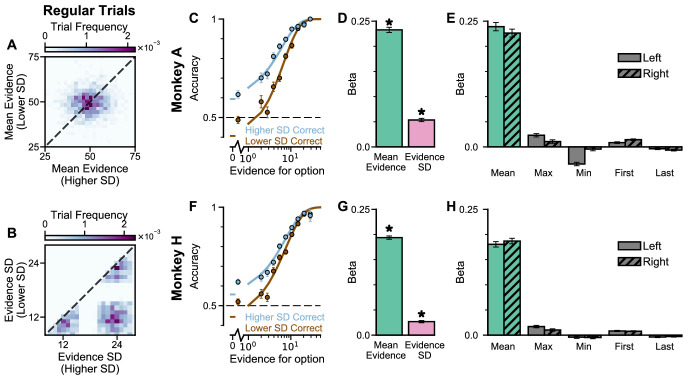
Extra information on Regular Trials, separated by subjects.In the regular-trials, each of the two streams is randomly chosen to be either narrow (μN∈[47,53], σN=12), or broad (μB∈[44,56], σB=24), then divided into ‘Lower SD’ or ‘Higher SD’ options post-hoc, depending on the sampled standard deviation of evidence relative to the other option. (A) The distribution of the mean evidence of ‘Lower SD’ and ‘Higher SD’ streams, across all regular trials for both monkeys. (B) The distribution of the evidence variability of ‘Lower SD’ and ‘Higher SD’ streams, across all regular trials for both monkeys. (C) The psychometric function of Monkey A when either the ‘Lower SD’ (brown) or ‘Higher SD’ (blue) stream is correct. (D) A regression model using evidence mean and variability to predict the animals’ choices. Each regressor is the left-right difference of the mean and standard deviation of the evidence streams. This shows that both statistics are utilised by Monkey A to solve the task (Mean Evidence: t = 45.90, p < 10−10; Evidence Standard Deviation: t = 16.68, p < 10−10). (E) A regression model including the mean, maximum, minimum, first, and last evidence values of both the left and right streams as regressors, in order to evaluate the contribution of each quantity and the possibility that the monkey is utilising strategies alternative to evidence integration and pro-variance bias. Evidently, Monkey A mainly relies on temporal integration to solve the task, as indicated by a strong mean evidence coefficient in both regression models. See also Supplementary files 1, 2, 3 for cross-validation analysis comparing regression models including various combinations of these predictors. (F–H) Same as (C–E) but for Monkey H. The statistics of the regression model in (G) are (Mean Evidence: t = 58.88, p < 10−10; Evidence Standard Deviation: t = 12.08, p < 10−10). All errorbars indicate the standard error.